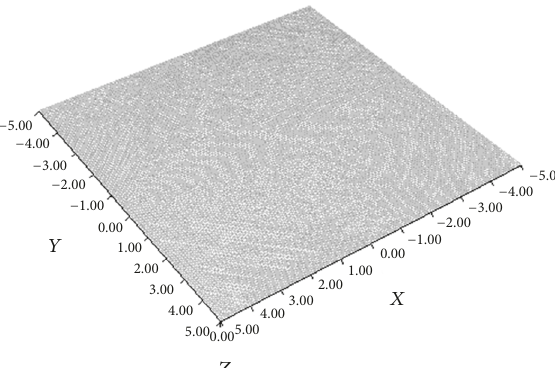
Figure 1: Mesh of the domain [−5,5] × [−5, 5]